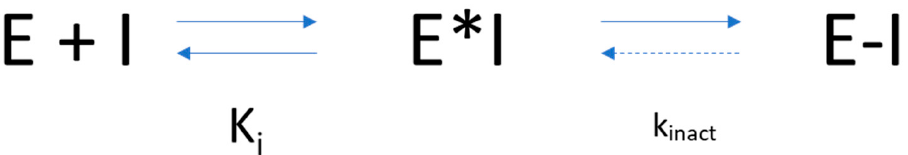
Scheme 1. A two-step mechanism of covalent inhibition. E = enzyme, I = covalent inhibitor, E*I = non- covalent complex, and E-I = covalent complex. While K i depends on non-covalent interactions, k inact is influenced by intrinsic compound